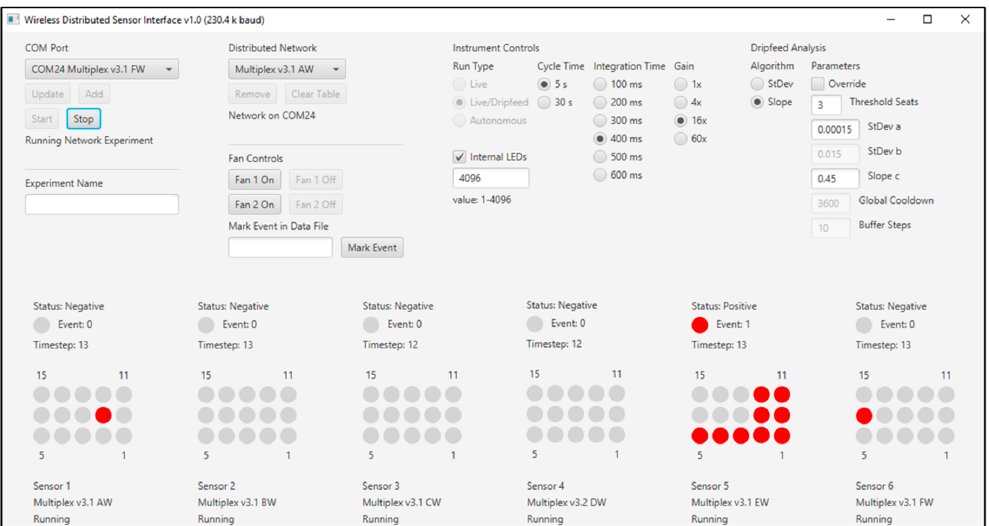
Figure 3. Image of the graphical user interface (GUI) for the ABEAM-15. This image shows single indicators under event detection conditions for Sensor 1 and Sensor 6, a condition insufficient for triggering positive status under the three indicator requirements being used. Sensor 5 is in positive status with nine indicators under event detection conditions. Here, a 5 s sampling cycle is used with 400 ms integration.